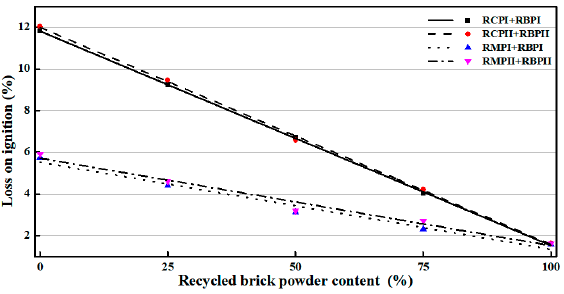
Figure 8. The LOI experiment results of various RPs.